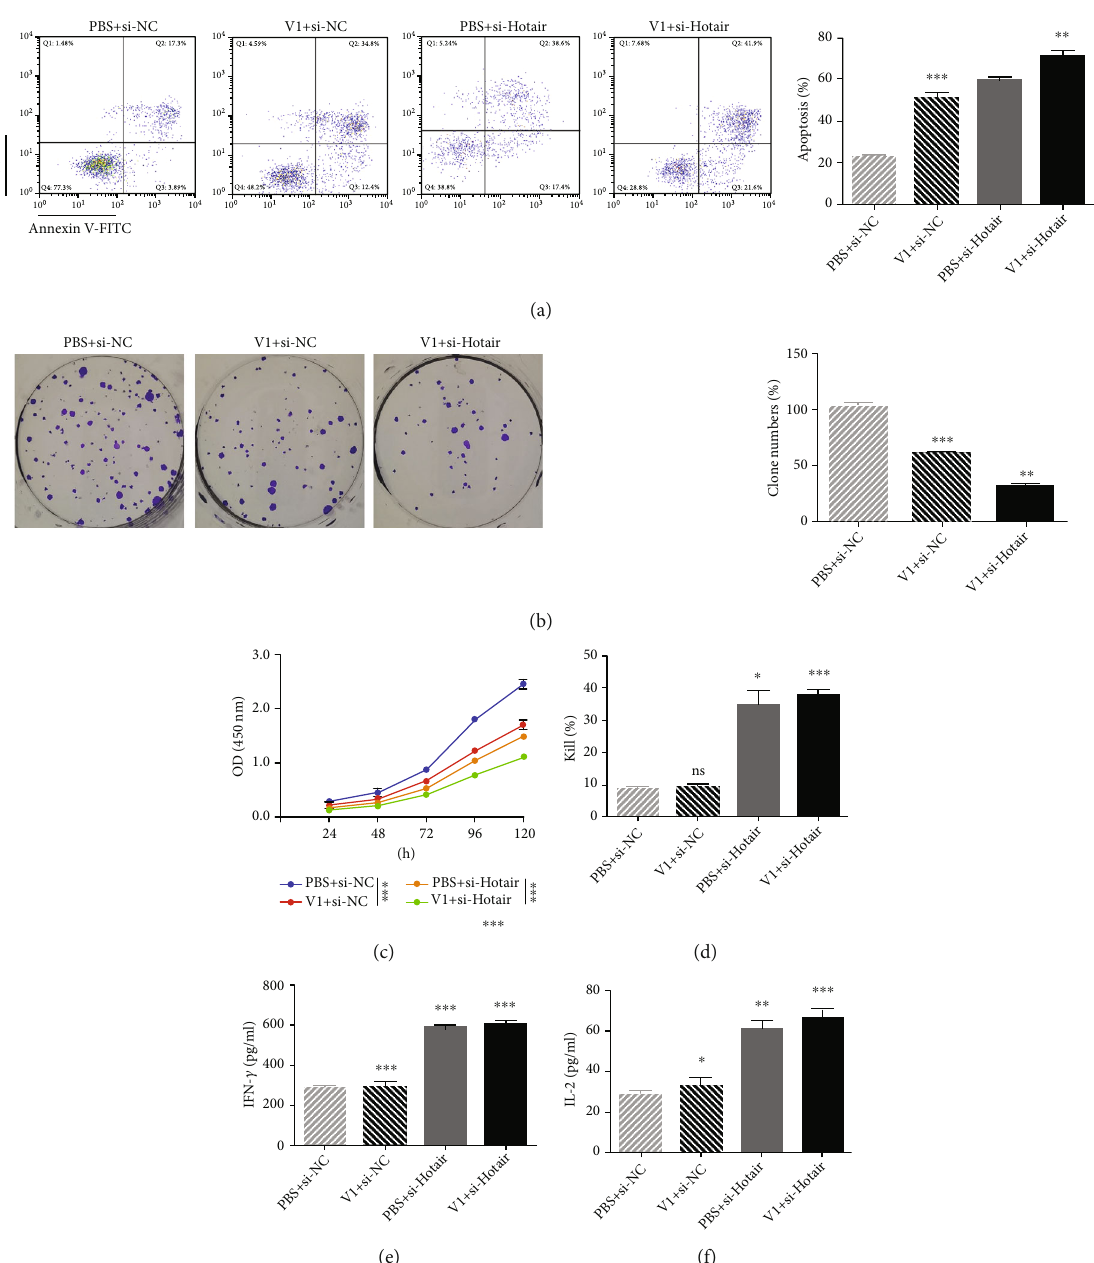
Figure 4: The combined si-Hotair and VEGF inhibitor show a better antitumor proliferation and anti-immune escape in vitro. The (a) apoptosis, (b) colony formation, and (c) viability of Hep-2 cells treated with PBS+si-NC, VEGF inhibitor V1+si-NC, PBS+si-Hotair, and VEGF inhibitor V1+si-Hotair, respectively. (d) T cell killing assay of each Hep-2 cell group cocultured with PBMC, and ELISA kit analyzed the concentration of cytokines (e) IFN- γ and (f) IL-2. Data are mean ± SD of at least three independent experiments; ∗ p < 0 : 05 ; ∗∗ p < 0 : 01 ; ∗∗∗ p < 0 : 001